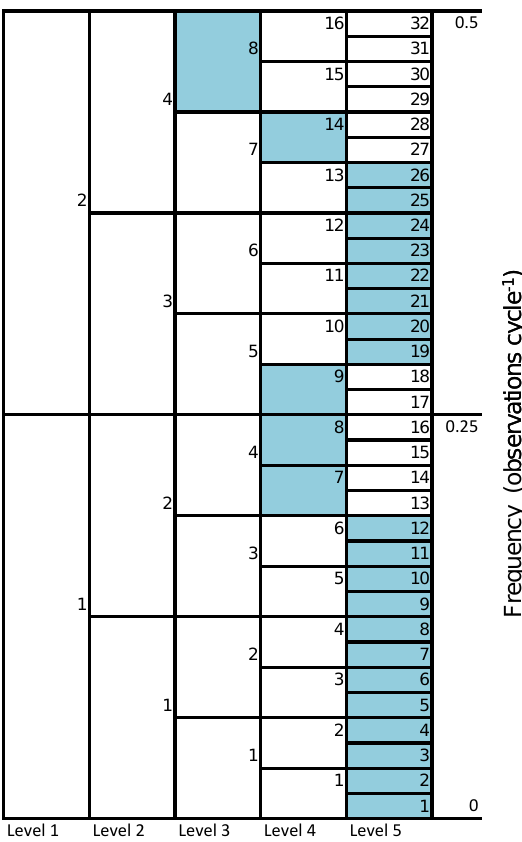
Fig. 5. The “best bases” for wheat biomass. The nominal partition of the frequency interval by the MODWPT to level 5 is shown with the best bases indicated by the shading. Packet associated with filter u k , m is identified by level number k on the bottom of the grid, and packet number m in the